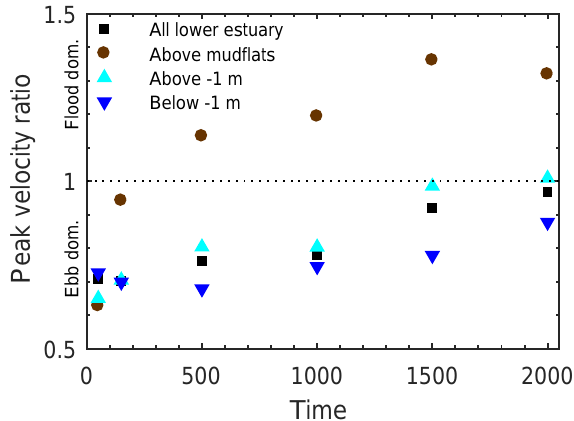
Figure 5. Flood–ebb peak velocity ratio over time for the first 5km of the default estuary (run 01) integrated over the total area (black squares), the area above mudflats (brown circles) and ar- eas above (cyan triangles) and below (blue triangles) the − 1m bed